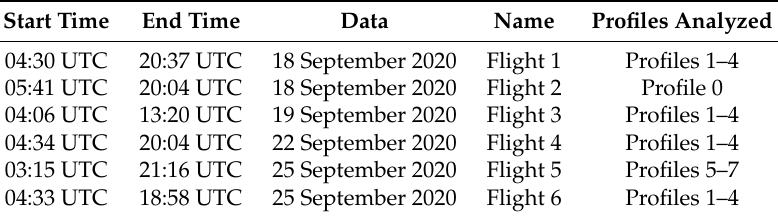
Table 1. Aerosonde UAS flights analysed in the presented